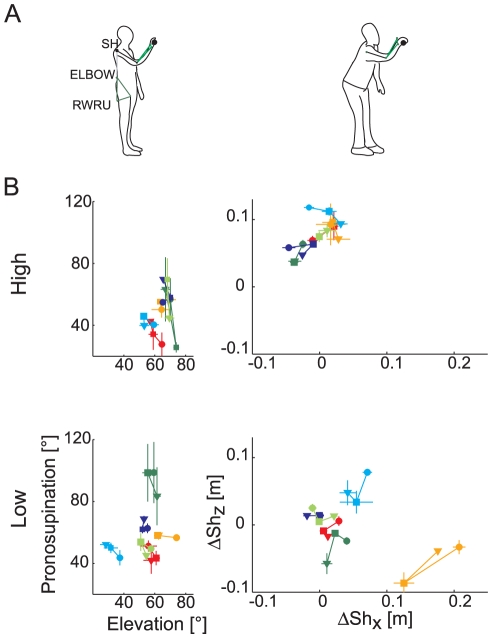
Wrist posture and trunk displacement at impact.(A) Examples of different body and arm postures at impact in two subjects (S5
left, S6
right). (B) Left panel: scatter plots of the forearm pronosupination angle vs. forearm elevation angle (mean ± SE across trials of the same condition; SE are reported only when number of trials per block was larger than 2). Right panel: shoulder displacement in the sagittal (x-z) plane between launch and impact times. It was not possible to determine Subject 3 behavior in the T3Z2 condition since the shoulder marker detached and was missing throughout the entire block. Subject color coding as in Figures 2 and 3.